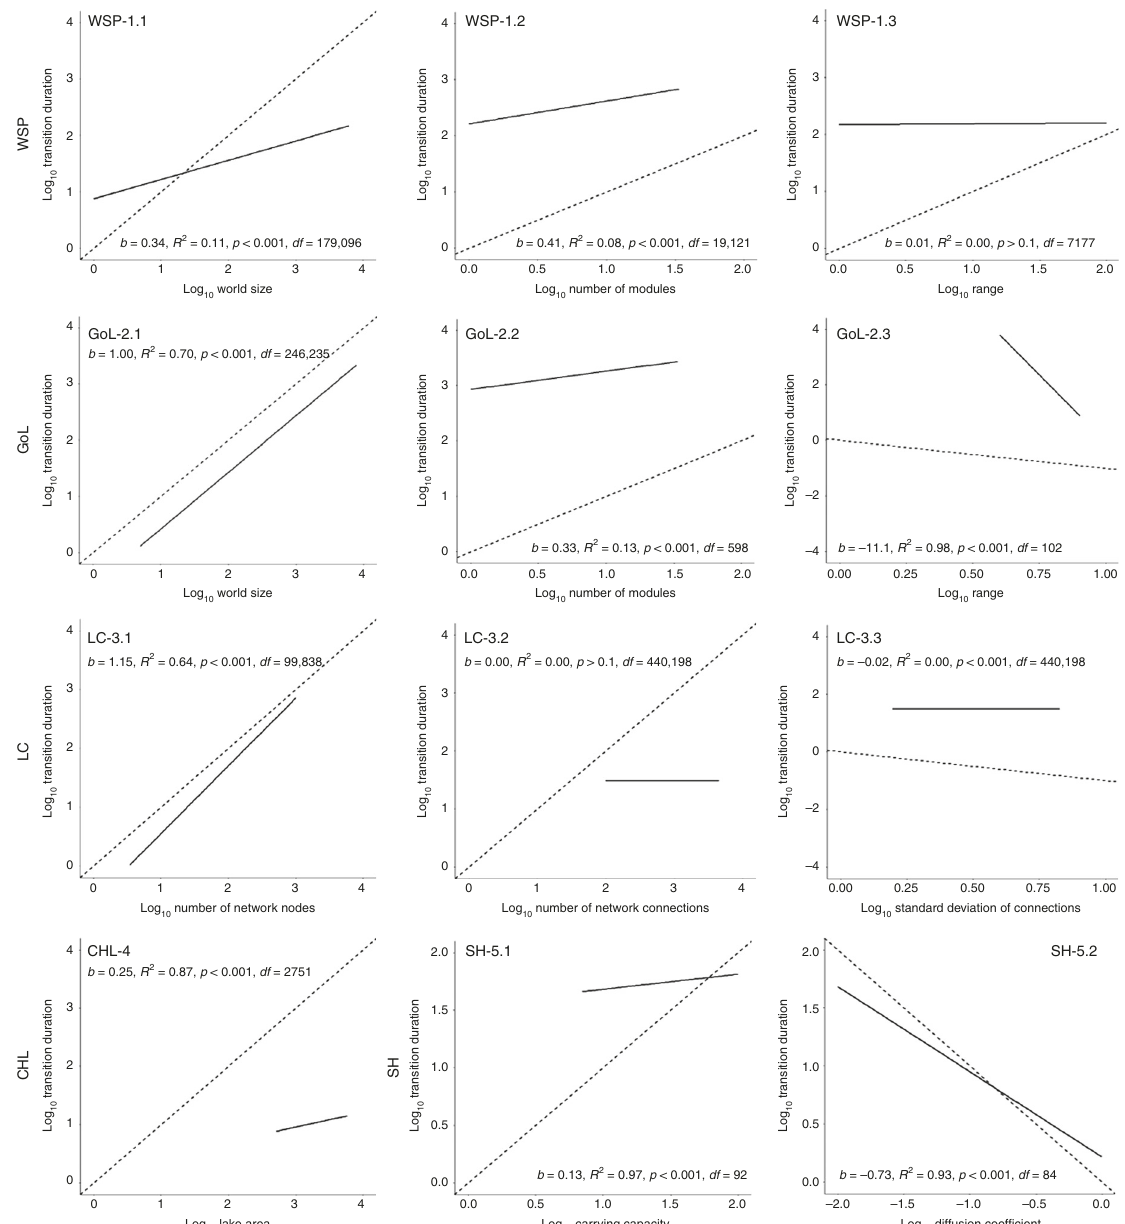
Fig. 3 Modelled outputs exploring the relationships between regime shift duration and twelve spatial characteristics. The trend lines and regression coef fi cients resulting from the twelve simulation experiments (#1.1 – #5.2) show the effects of different spatial properties on the duration of system shift (Table 1). Dashed lines are 1:1 reference lines plotted with a y -intercept of ‘ 0 ’ . Log – log axes are used for consistency with Fig. 1, with the ‘ b-term ’ representing the slope of the regression model. See Supplementary Table 8 for the linear model coef fi cients and